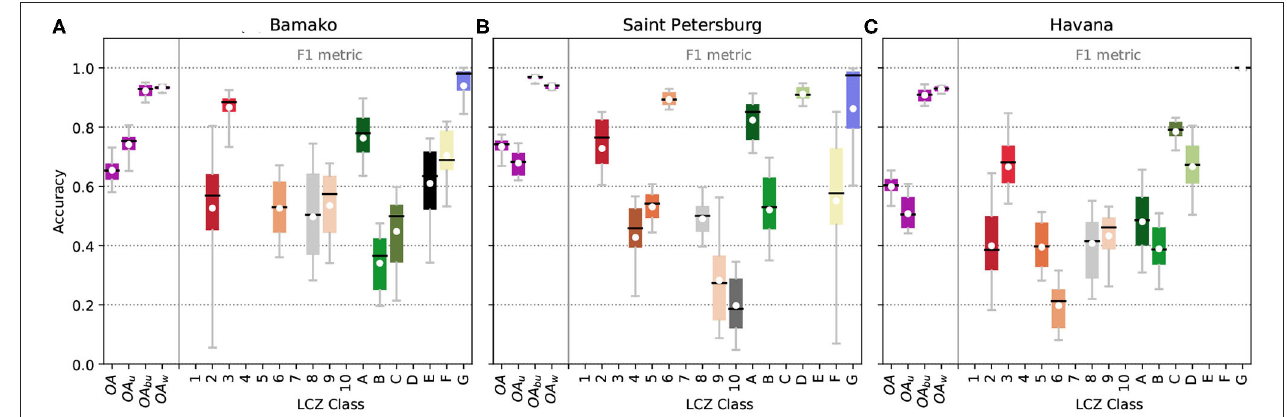
FIGURE 6 | Accuracies for (A) Bamako, (B) Saint Petersburg, and (C) Havana. The purple colors in the box plots refer to the overall accuracy metrics, while the LCZ colored boxes reflect the class-wise F1 metric. Mean and median are depicted by a white dot and black line respectively, boxes indicate the interquartile range and whiskers the 5 to 95th quartile